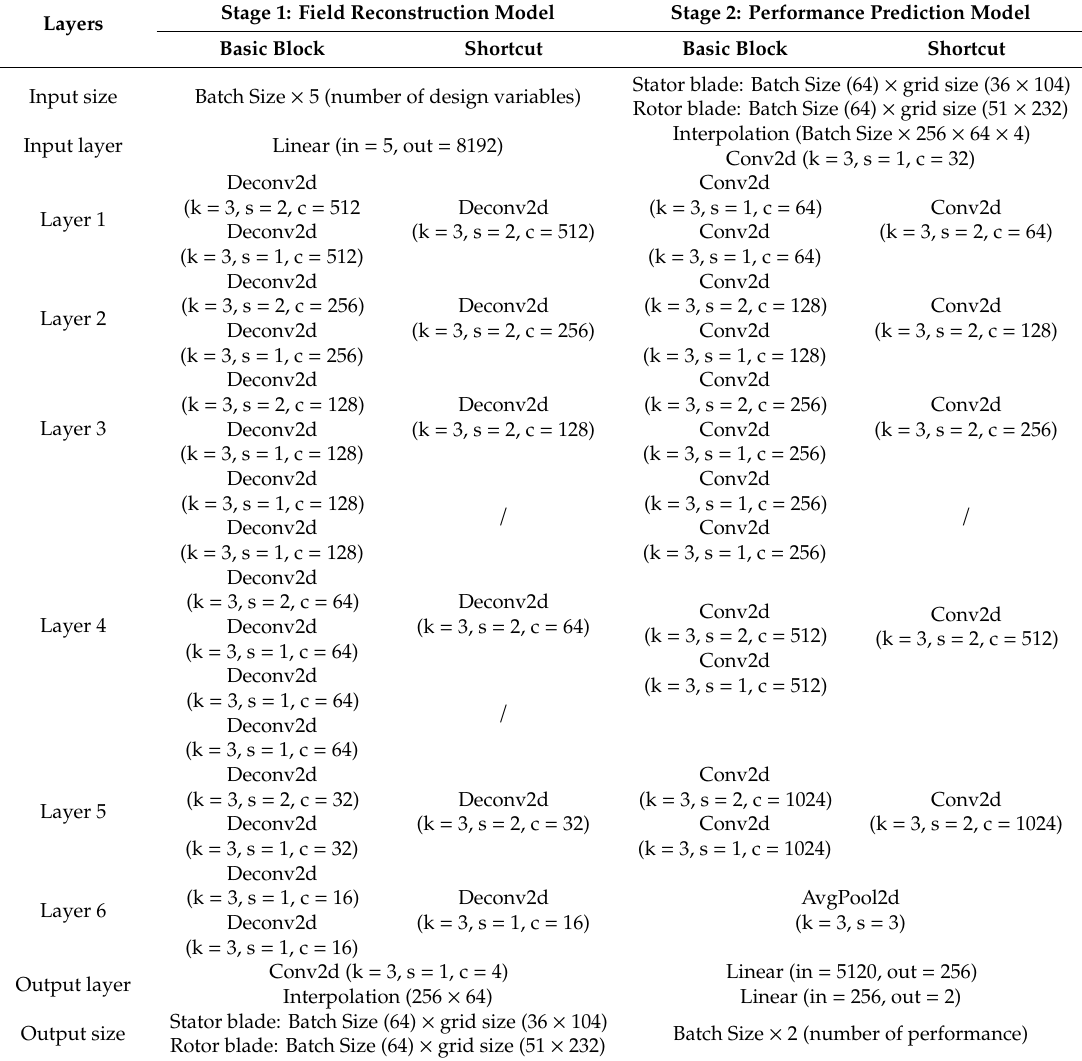
Table 1. Architecture of two-stage deep convolutional neural